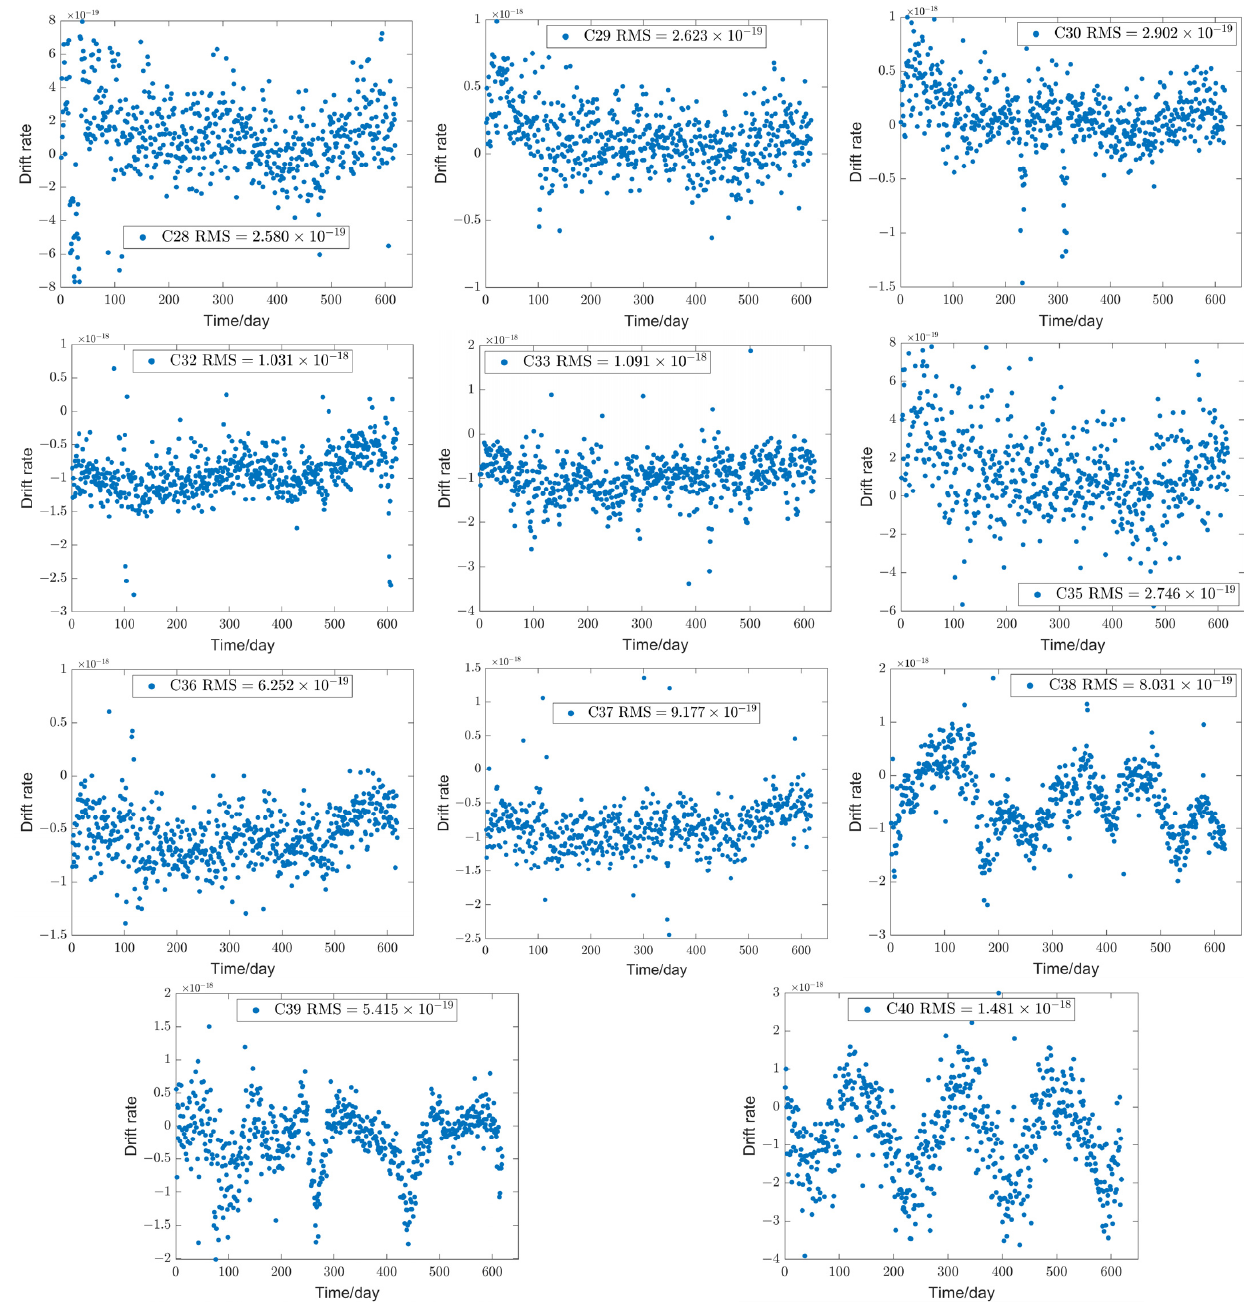
Figure 7. Drift rate of BDS satellite